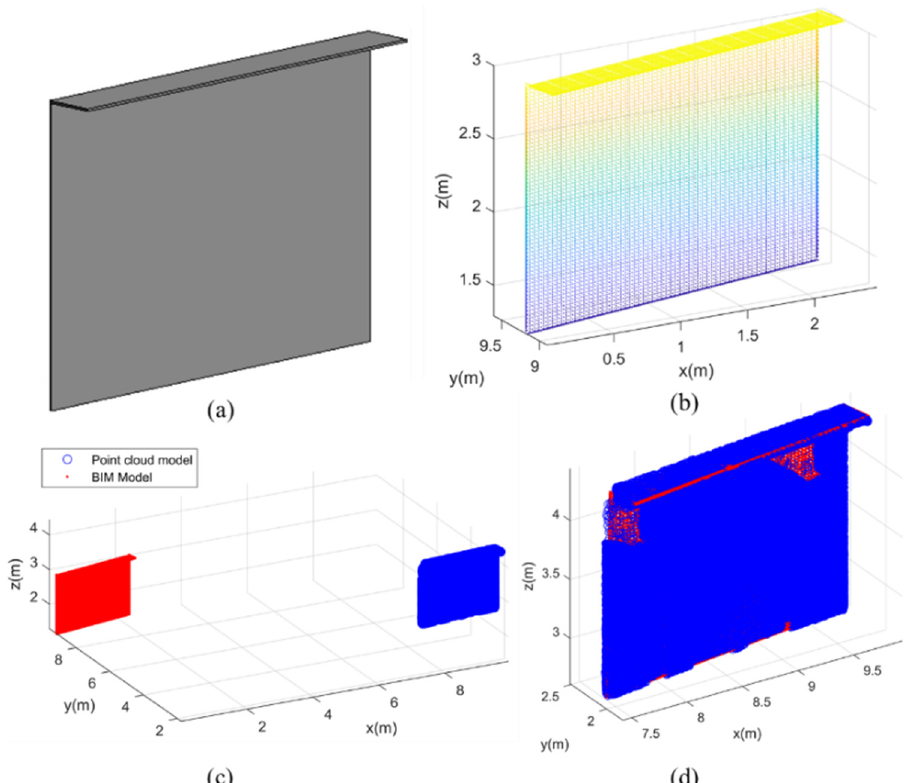
Figure 7. Geometric quality assessment of the steel cabin: ( a ) BIM model of the steel cabin; ( b ) generated point-cloud model; ( c ) alignment between as-designed and as-is prefabricated steel cabin; and ( d ) point-cloud data after coarse and fine registration.